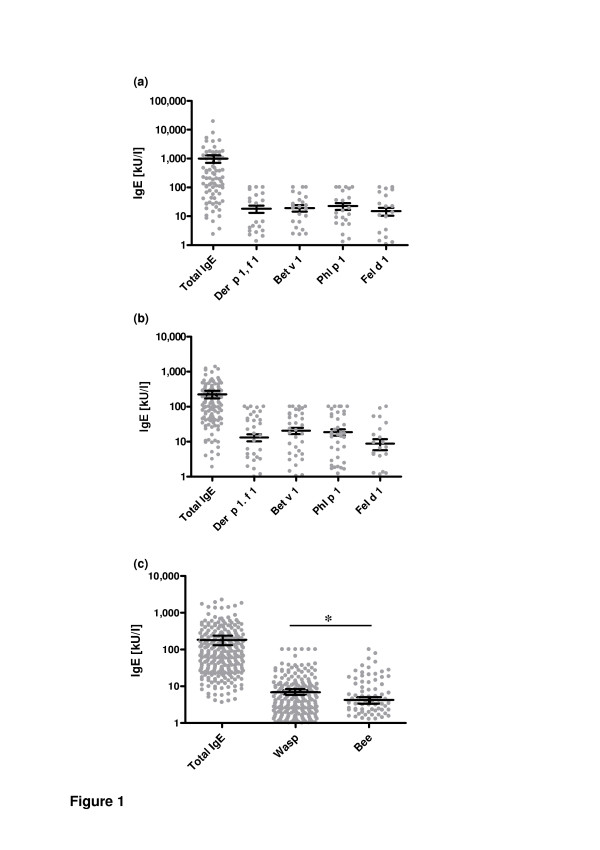
Total and specific IgE levels. Means ± SEM of total and specific IgE [kU/l] for Der p 1/f 1, Bet v 1, Phl p 1, and Fel d 1 in patients with (a) AD and with (b) allergic asthma or rhinitis as well as for (c) wasp and bee allergen in patients with insect allergy are shown. Total and specific IgE is sicnificantly increased in patients with AD compared with patients suffering from allergic asthma or rhinitis and insect allergy.